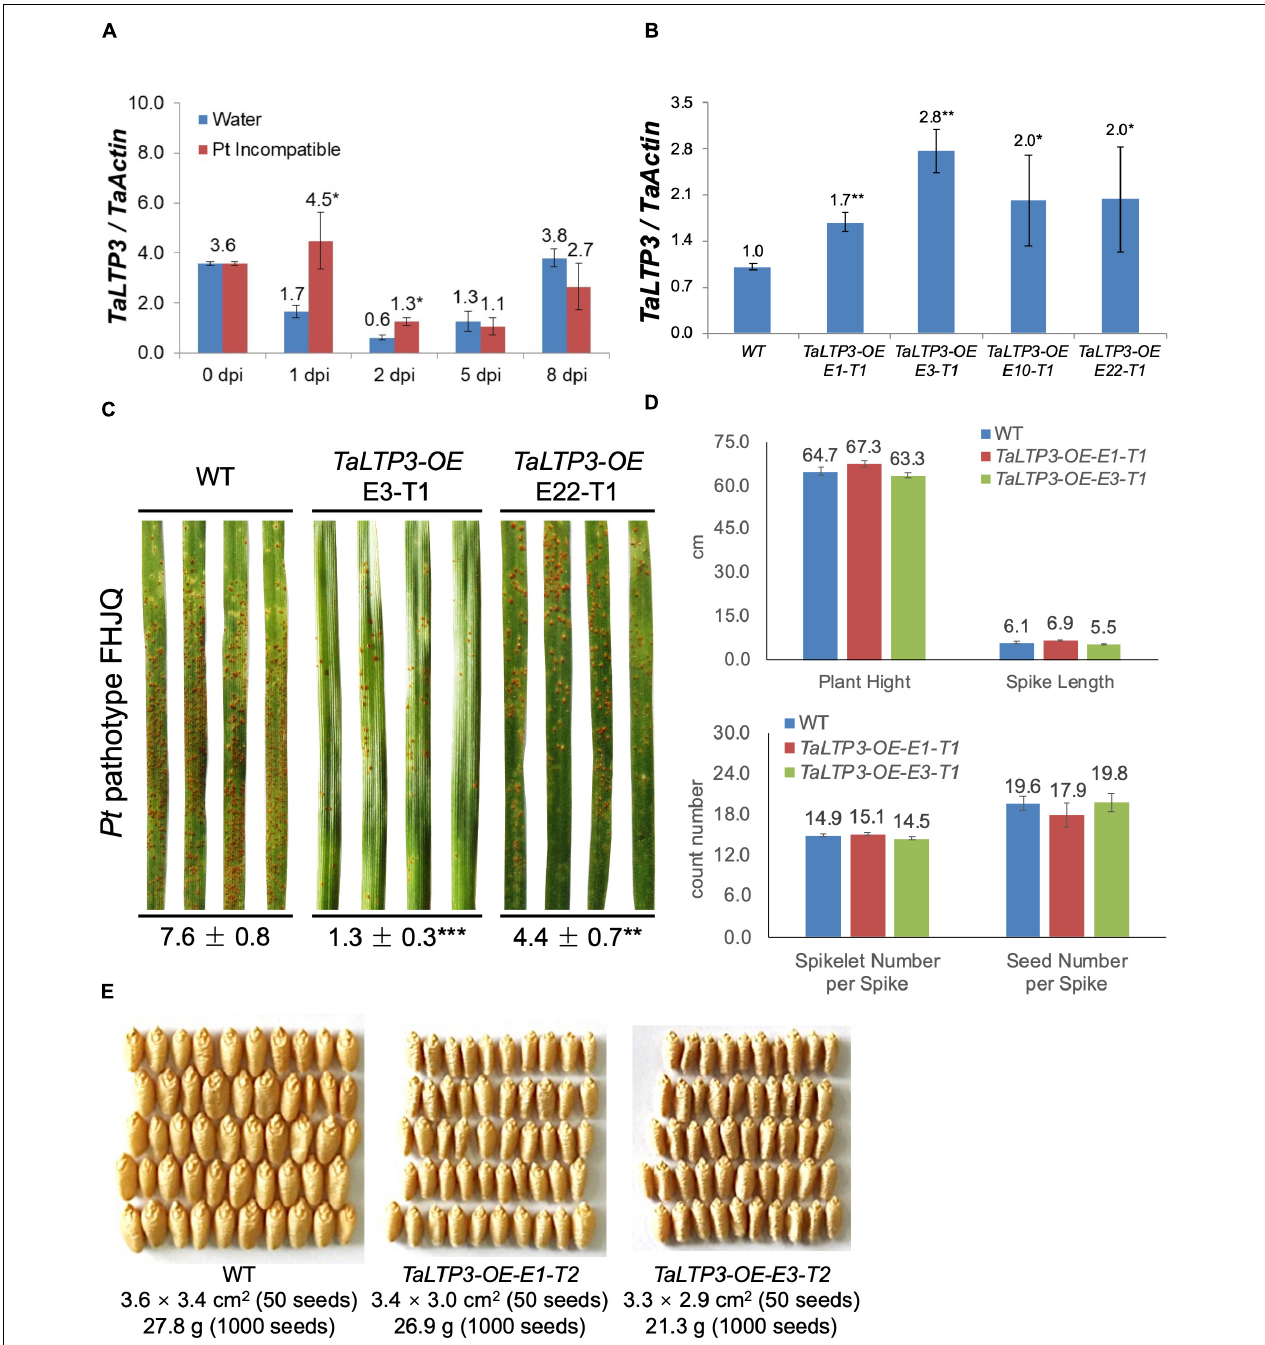
FIGURE 1 | TaLTP3 was involved in wheat resistance to leaf rust. (A) Expression levels of TaLTP3 during Lr39/41 -mediated wheat resistance toward leaf rust were evaluated by quantitative PCR (qPCR) assay. Leaf samples were collected at 0, 1, 2, 5, and 8 days postinoculation (dpi) with water (control) and avirulent Pt pathotype THTT. The transcript levels for all the genes were expressed as linearized fold- TaActin levels, which were calculated based on the formula 2 ( Actin Ct − Target Ct ) . Data were expressed as mean ± SE from four biological replicates. The asterisk indicated a significant difference ( p < 0.05) between the water control and Pt -inoculated samples by using the t -test. (B) The transcript level of TaLTP3 in transgenic wheat line overexpressing TaLTP3 and wild-type plants were evaluated by qPCR assay. (C) The susceptibility phenotypes of TaLTP3-OE and wild-type plants to the Pt pathotype FHJQ. The numbers below the images of the Pt -infected wheat leaves represent the average percentages of the rust sporulation area in each leaf. The asterisks (** p < 0.01, *** p < 0.0001) were annotated based on the comparison between the transgenic line and wild-type plants by the Dunnett’s test. (D) Agronomic traits of transgenic wheat line TaLTP3-OE and wild-type plants were investigated in greenhouse condition. (E) Seeds harvested from transgenic wheat line TaLTP3-OE and wild-type plants were compared in size and thousand grain weight.